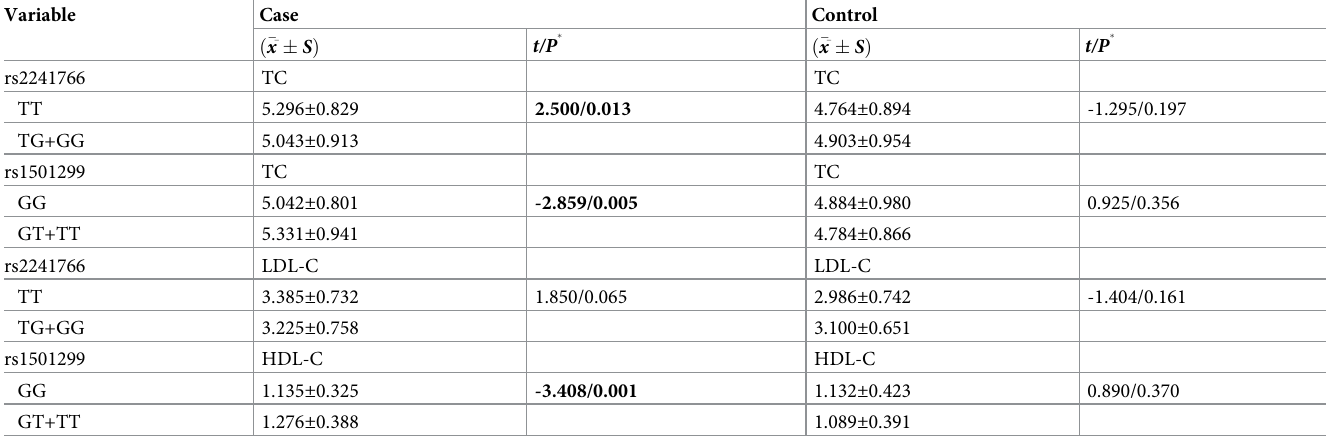
Table 7. Lipid levels in rs2241766 and rs1501299 genotypes.